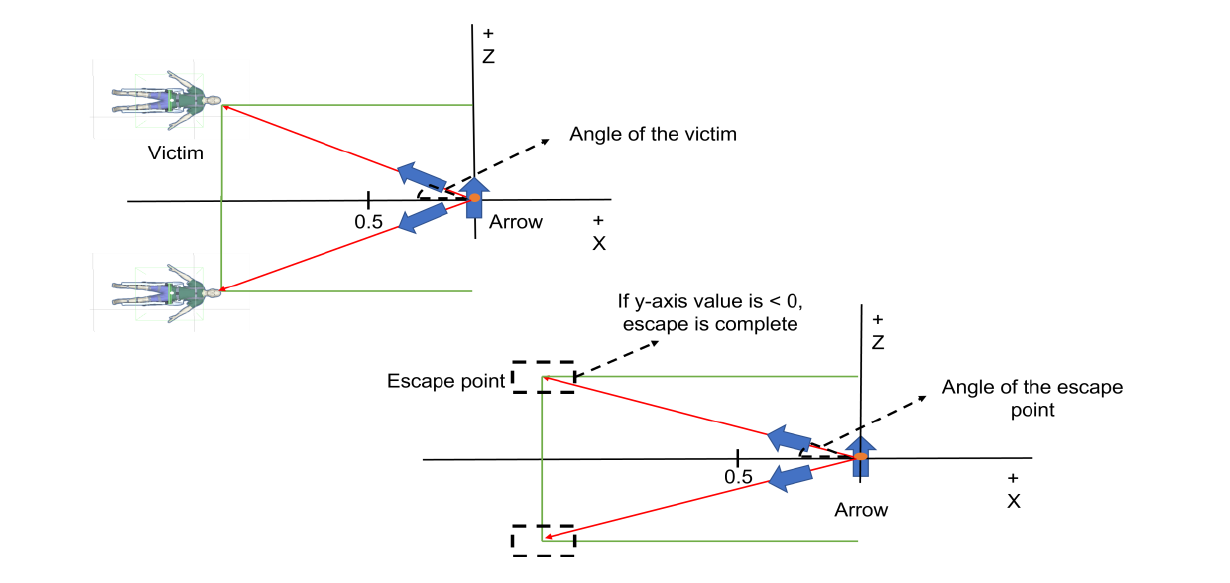
Figure 8. Navigation function guiding the user toward the victim and exit.